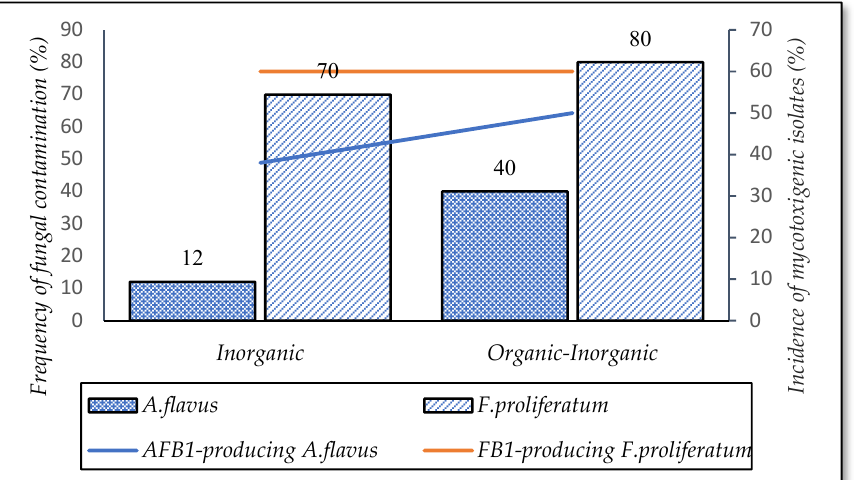
Figure 8. Incidence of fungal contamination and mycotoxigenic fungi in fertilizer applications.